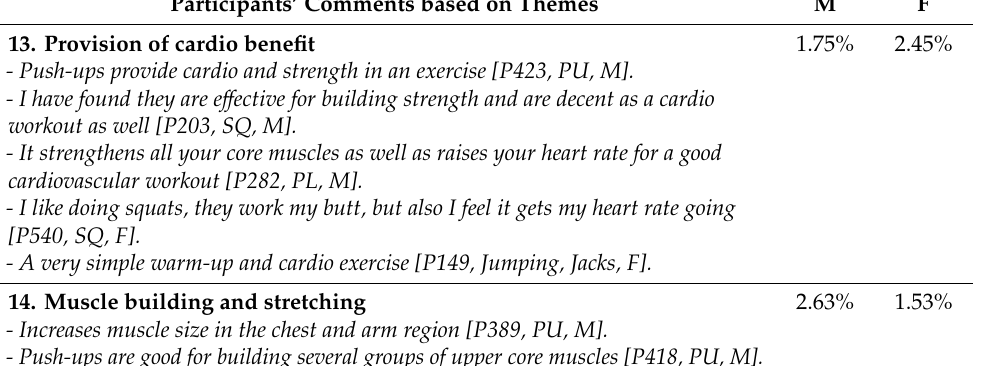
Table A1. Cont . Participants’ Comments based on